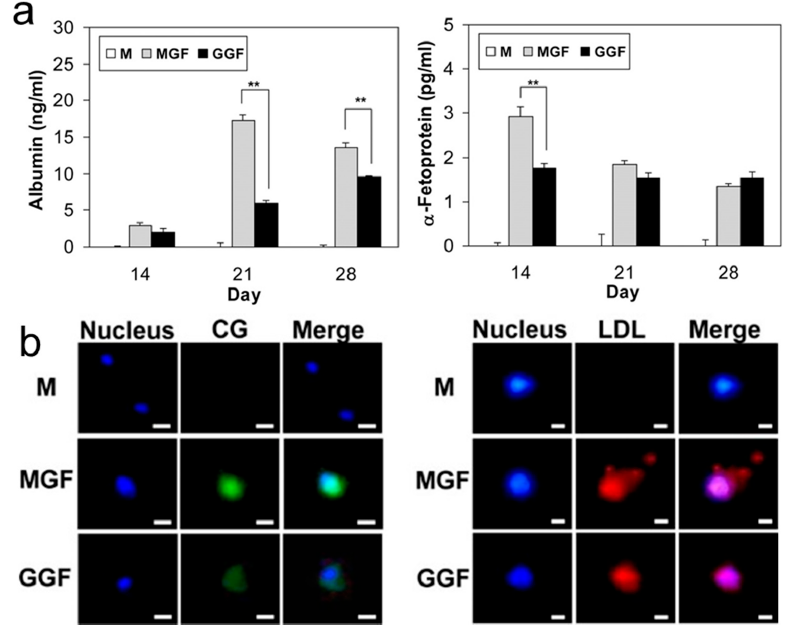
Figure 7. ( a ) Expression of albumin and α -fetoprotein by TMSCs in PEG-L-PA thermogel, * and ** indicate p < 0.05 by Student t -test; ( b ) Images of cellular uptake of CG and LDL in PEG-L-PA thermogels at 28 days. The scale bar is 10 μ m (reproduced with permission from [43]).